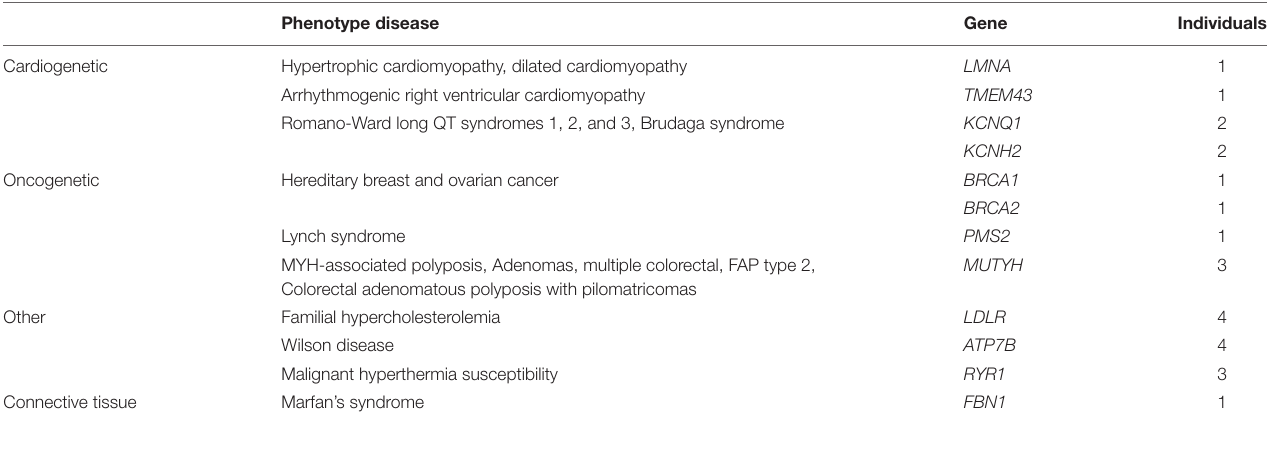
TABLE 1 | Table summarizing secondary findings per disease type. Phenotype